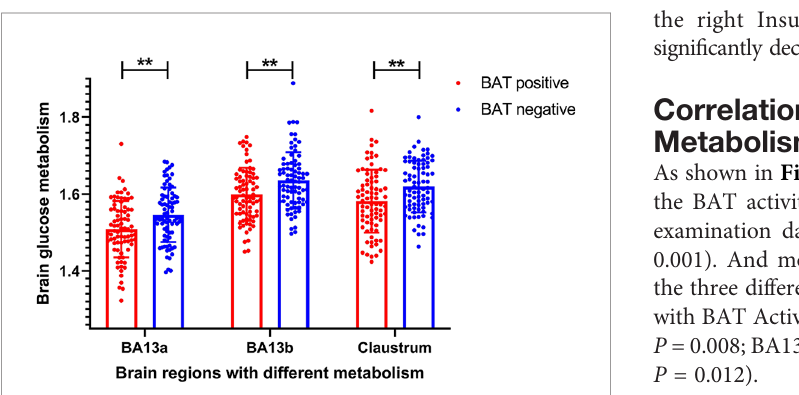
FIGURE 4 | Differences of semi-quantitative metabolic values of brain regions between BAT positive group and BAT negative group. The semi-quantitative metabolic values of three brain region in BAT positive group were signi fi cantly lower than these in BAT negative group (BA13 a P = 0.001; BA13 b P = 0.002; Right claustrum P = 0.002). BA denotes the Brodmann area. P values are based on Independent-Samples t Test. ** denotes P value < 0.01.